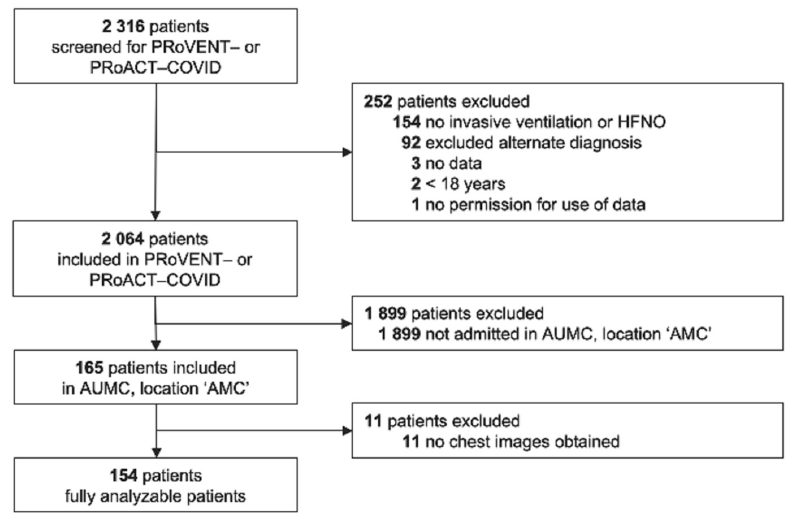
Figure 1. CONSORT diagram. Patient flow in the parent studies and for this analysis. Abbreviations: